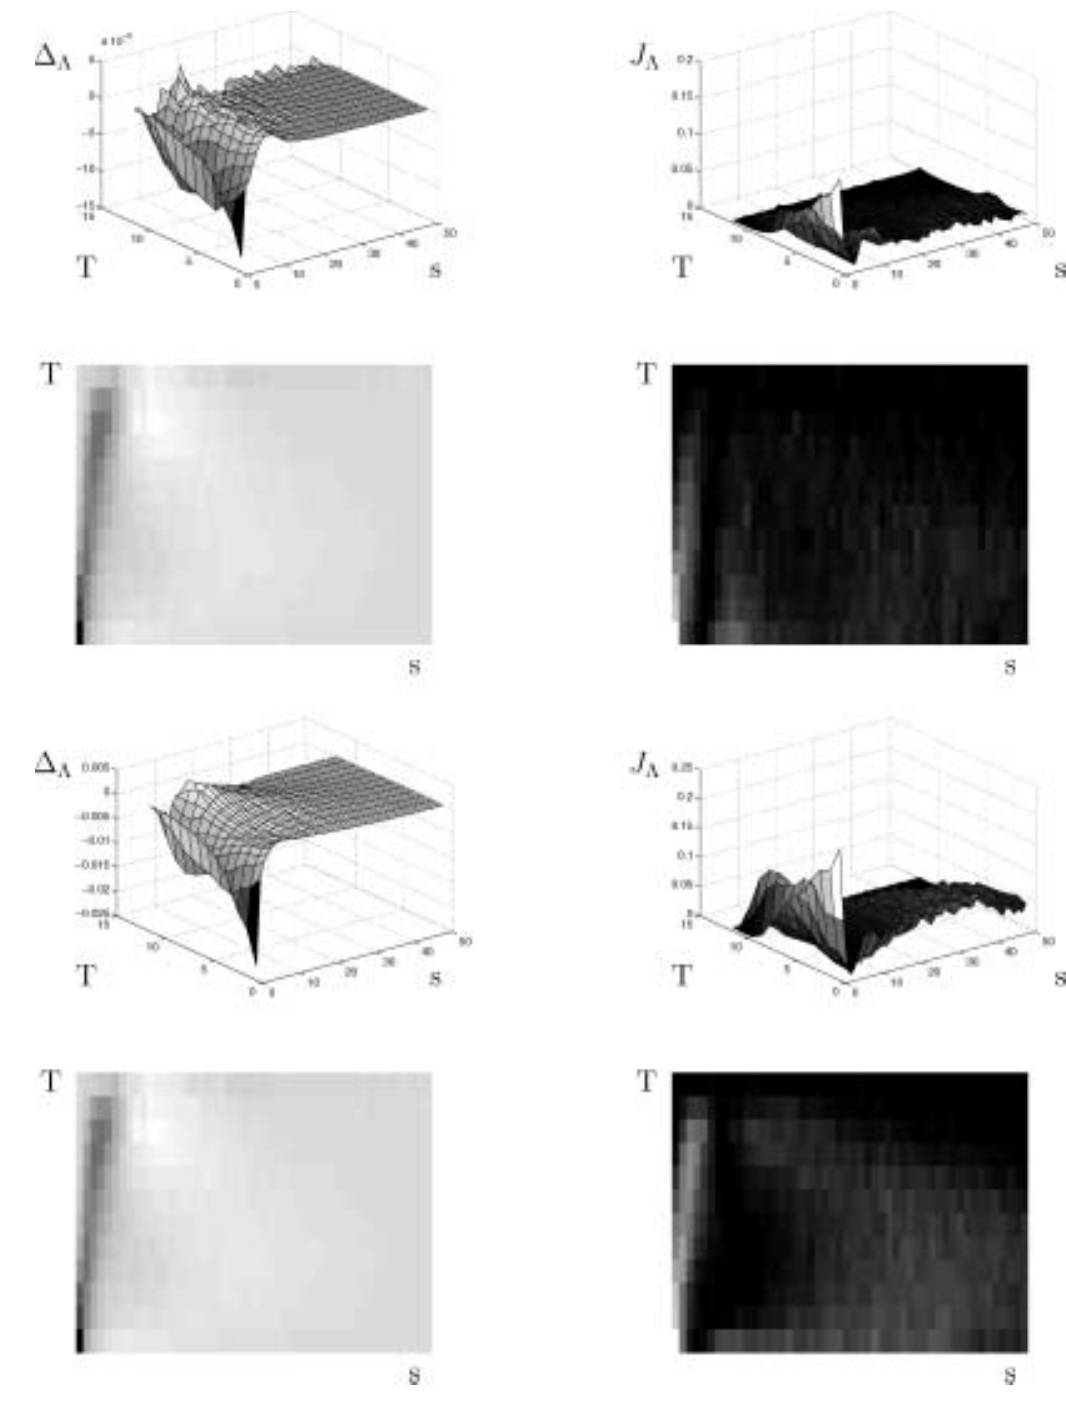
Fig. 7. Left: The Lacunarity Class Difference Matrix, ∆ Λ ( s , T | ω 1 , ω 2 ), computed from the peripheral 30% (upper) and the central 70% (lower) 1D segments of nuclei from monolayers. The positive values in the surface plot (and the lighter areas in the gray-scale plot) correspond to matrix elements that are more probable for the good prognosis class than for the bad prognosis class. Right: The Mahalanobis Class Distance Matrix, J Λ ( s , T | ω 1 , ω 2 ), between the good and bad prognosis classes, based on the lacunarity matrices, computed from the peripheral 30% (upper) and central 70%